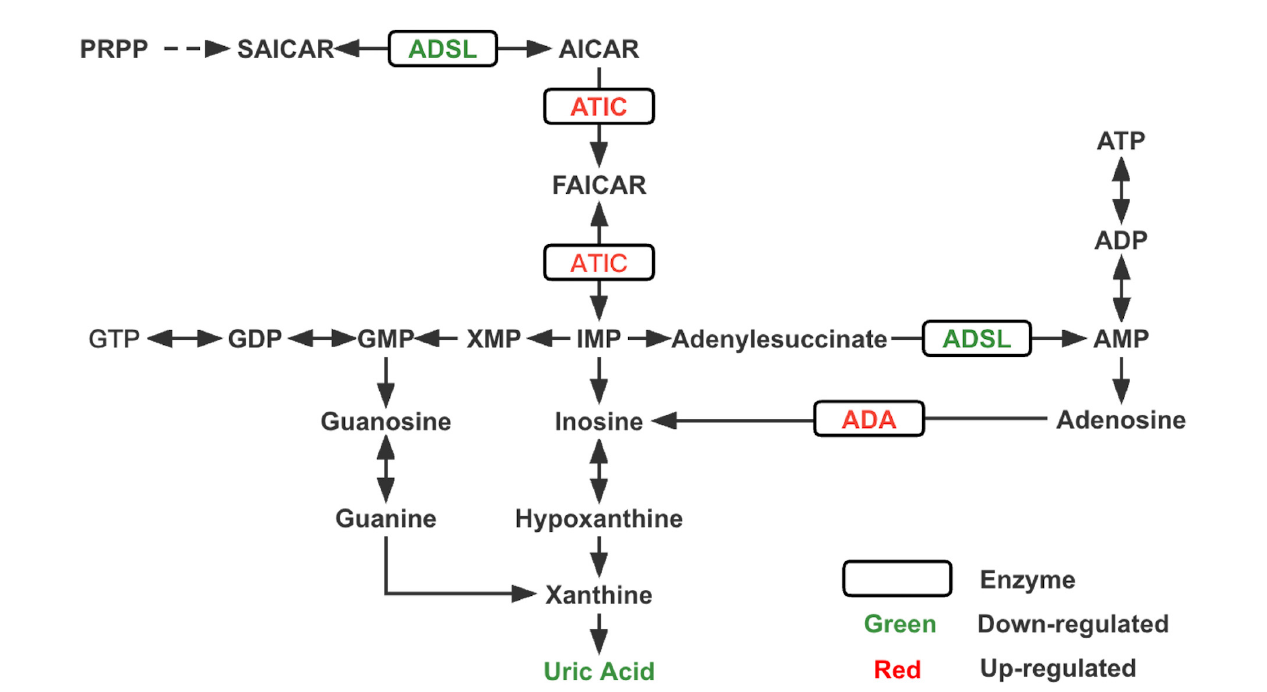
FIGURE3 Changes in key enzymes and the end product uric acid in the purine metabolism pathway of ASD. PRPP, phosphoribosylpyrophosphate; SAICAR, succinylaminoimidazole carboxamide ribotide; AICAR, aminoimidazole carboxamide ribotide; FAICAR, formyloaminoimidazole carboxamide ribotide; IMP, inosine monophosphate; AMP, adenine monophosphate; ADP, adenosine diphosphate; ATP, adenosine triphosphate; XMP, xanthine monophosphate; GMP, guanine monophosphate; GDP, guanine diphosphate; GTP, guanine triphosphate; ADSL, adenylosuccinate lyase;